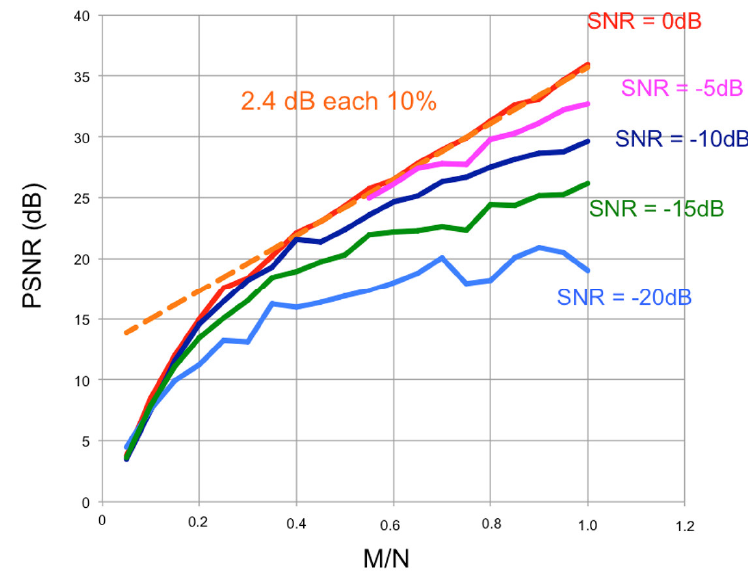
Figure 5. PSNR in function of M/N and SNR (simulated data).